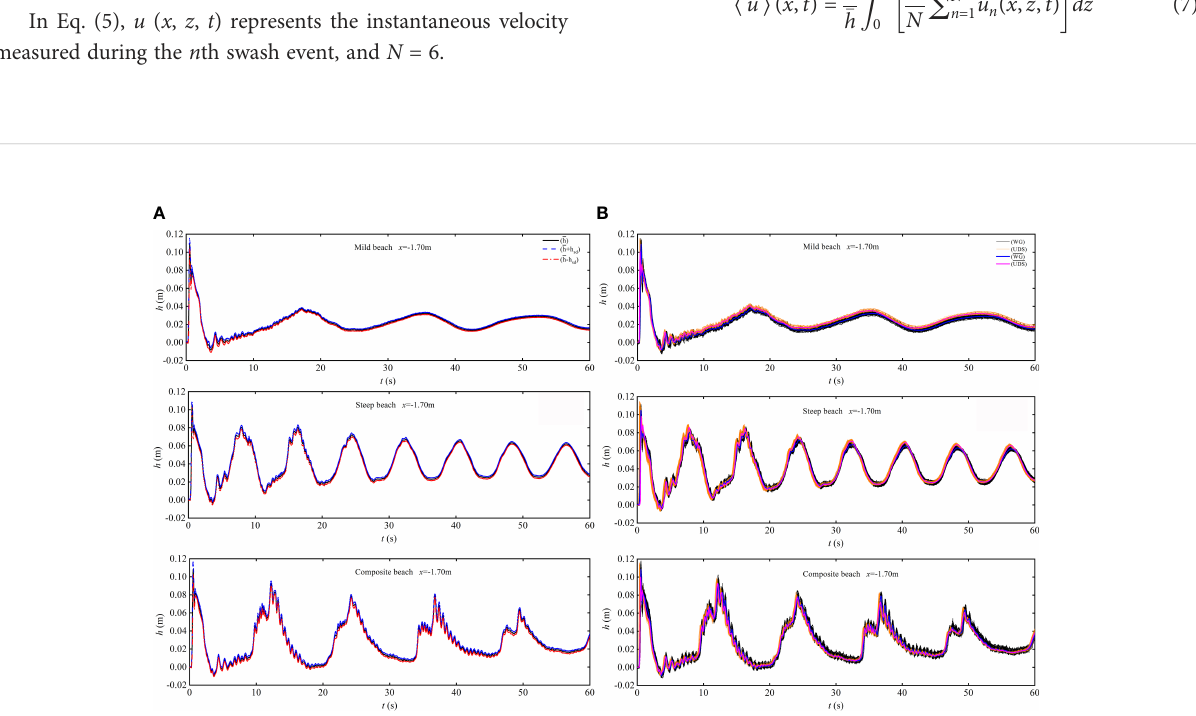
FIGURE 3 (A) Ensemble-averaged depth time-series (cid:1) h ( x , t ) and (cid:1) h ( x , t ) ± h sd comparison at x = − 1.70 m on the three beaches; (B) the comparison of ensemble-averaged depth time series between both WG and UDS at x = − 1.70 m on the three beaches.